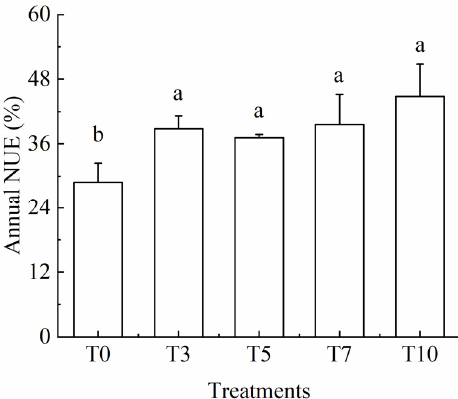
Figure 3. Effects of different fertilization treatments on annual nitrogen use efficiency. NUE—nitrogen use efficiency. Columns with different small case letters show significant difference between different treatments at p < 0.05 by LSD’s multiple range test. Values are mean of four replicates and bars show standard deviation. CK, no nitrogen fertilizer applied; T0, 100% conventional urea (CU); T3, one-time basal application of slow-release urea (SRU) and CU mixture with 30% SRU; T5, one-time basal application of SRU and CU mixture with 50% SRU; T7, one-time basal application of SRU and CU mixture with 70% SRU; T10, one-time basal application of 100% SRU.